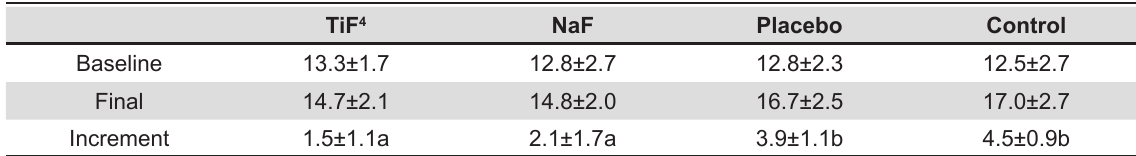
Table 1- Mean±standard deviation of the baseline, final and increment enamel erosive wear (µm) according to each treatment